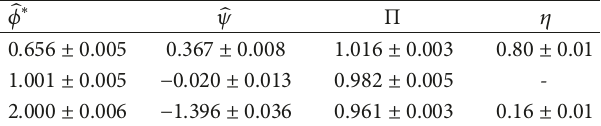
Table 2: 95% confidence intervals for global measurements in compressor mode, free windmill, and load-controlled windmill.